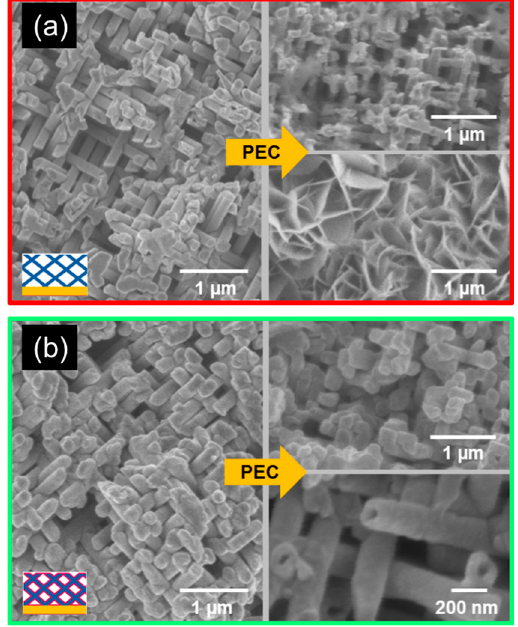
Figure 8. SEM images of ( a ) ZnO nanowire network and ( b ) ZnO/TiO 2 nanowire network taken before (left) and after (right) PEC measurements. The insets schematically display the cross-section of each sample, indicating the distribution of the various materials—namely, gold (yellow), ZnO (blue), and TiO 2 (pink).